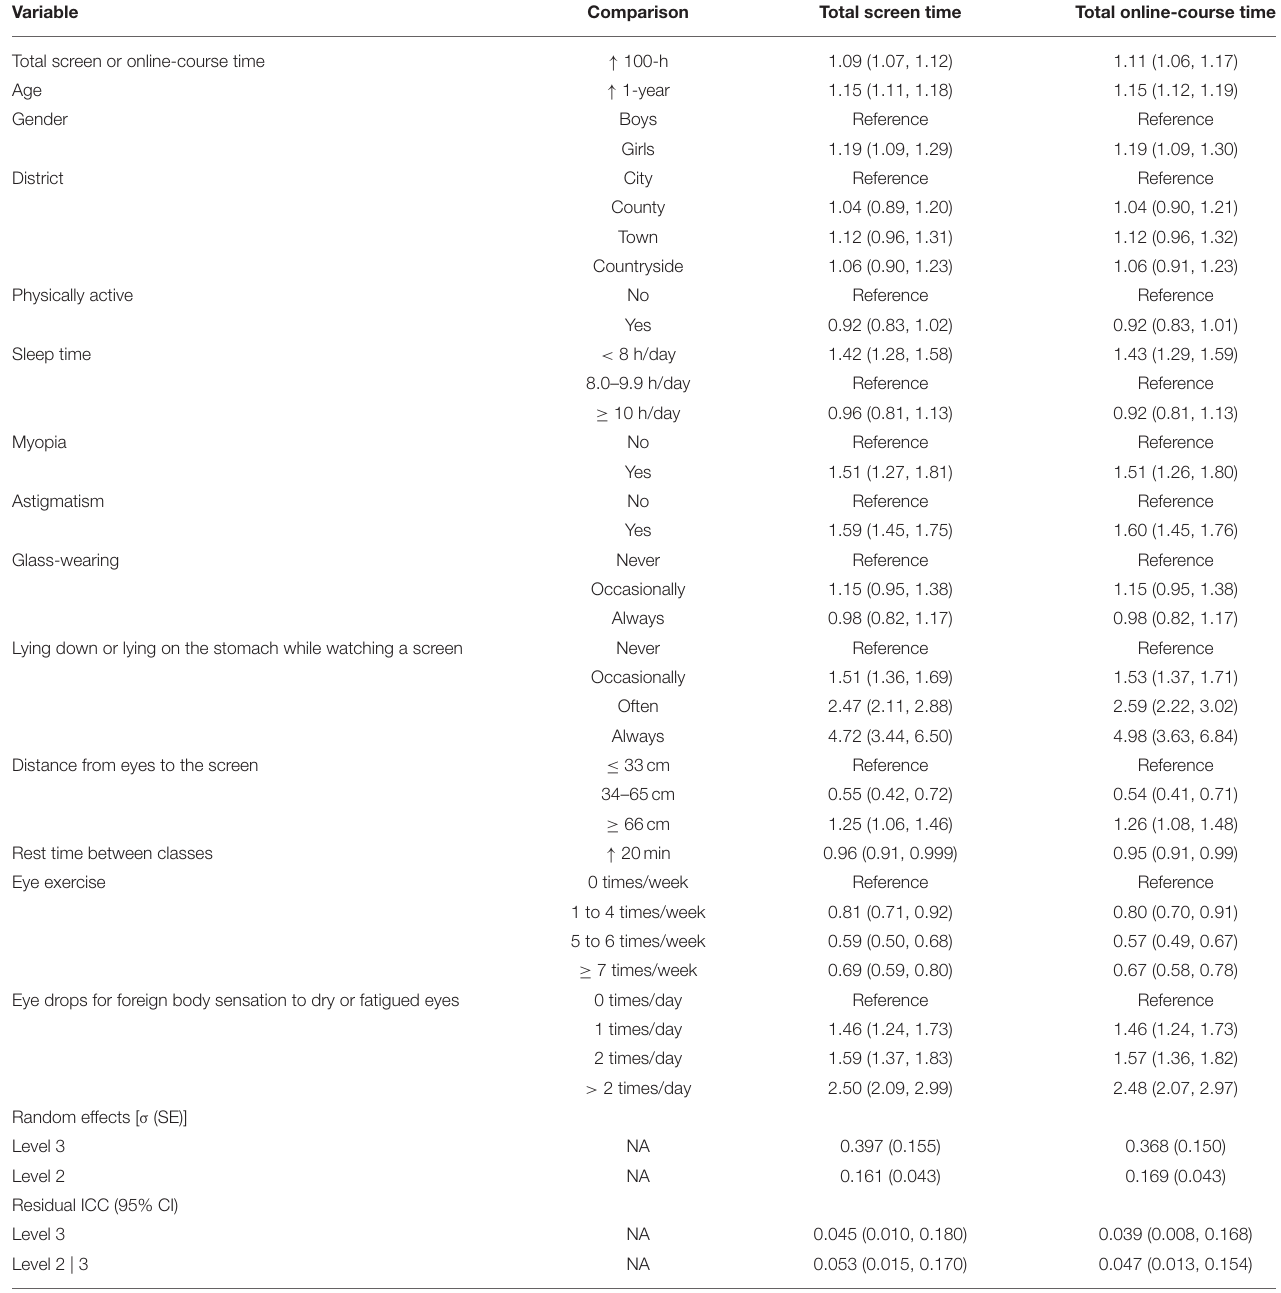
TABLE 4 | Multi-level multivariable-adjusted associations [OR (95% CI)] of the total screen/online-course time and related covariates with asthenopia risk a